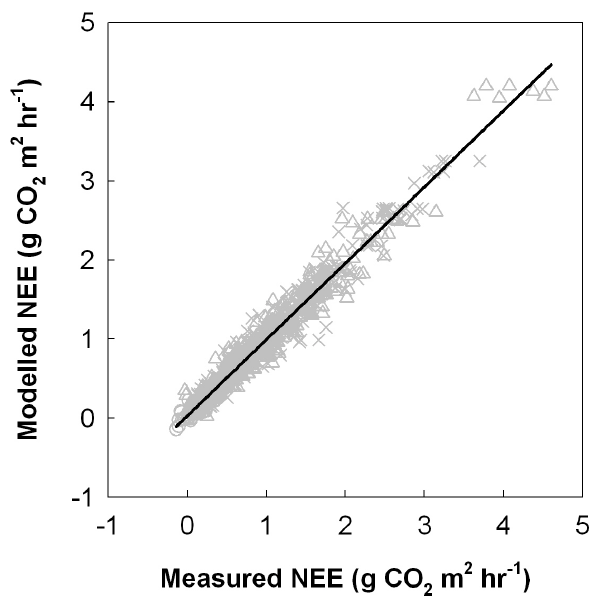
Fig. 1. Measured versus modelled forest floor NEE. Modelled NEE was estimated from a three parameter decay model fit to measure- ments. Positive values denote net release of CO 2 from the for- est floor into the atmosphere. Circles, triangles and crosses rep- resent measurements in the early, middle and late growing season respectively. The line is a linear regression fit through all the data ( y = 0 . 9652 x + 0.0268, R 2 = 0.95, root mean square error = 0 .